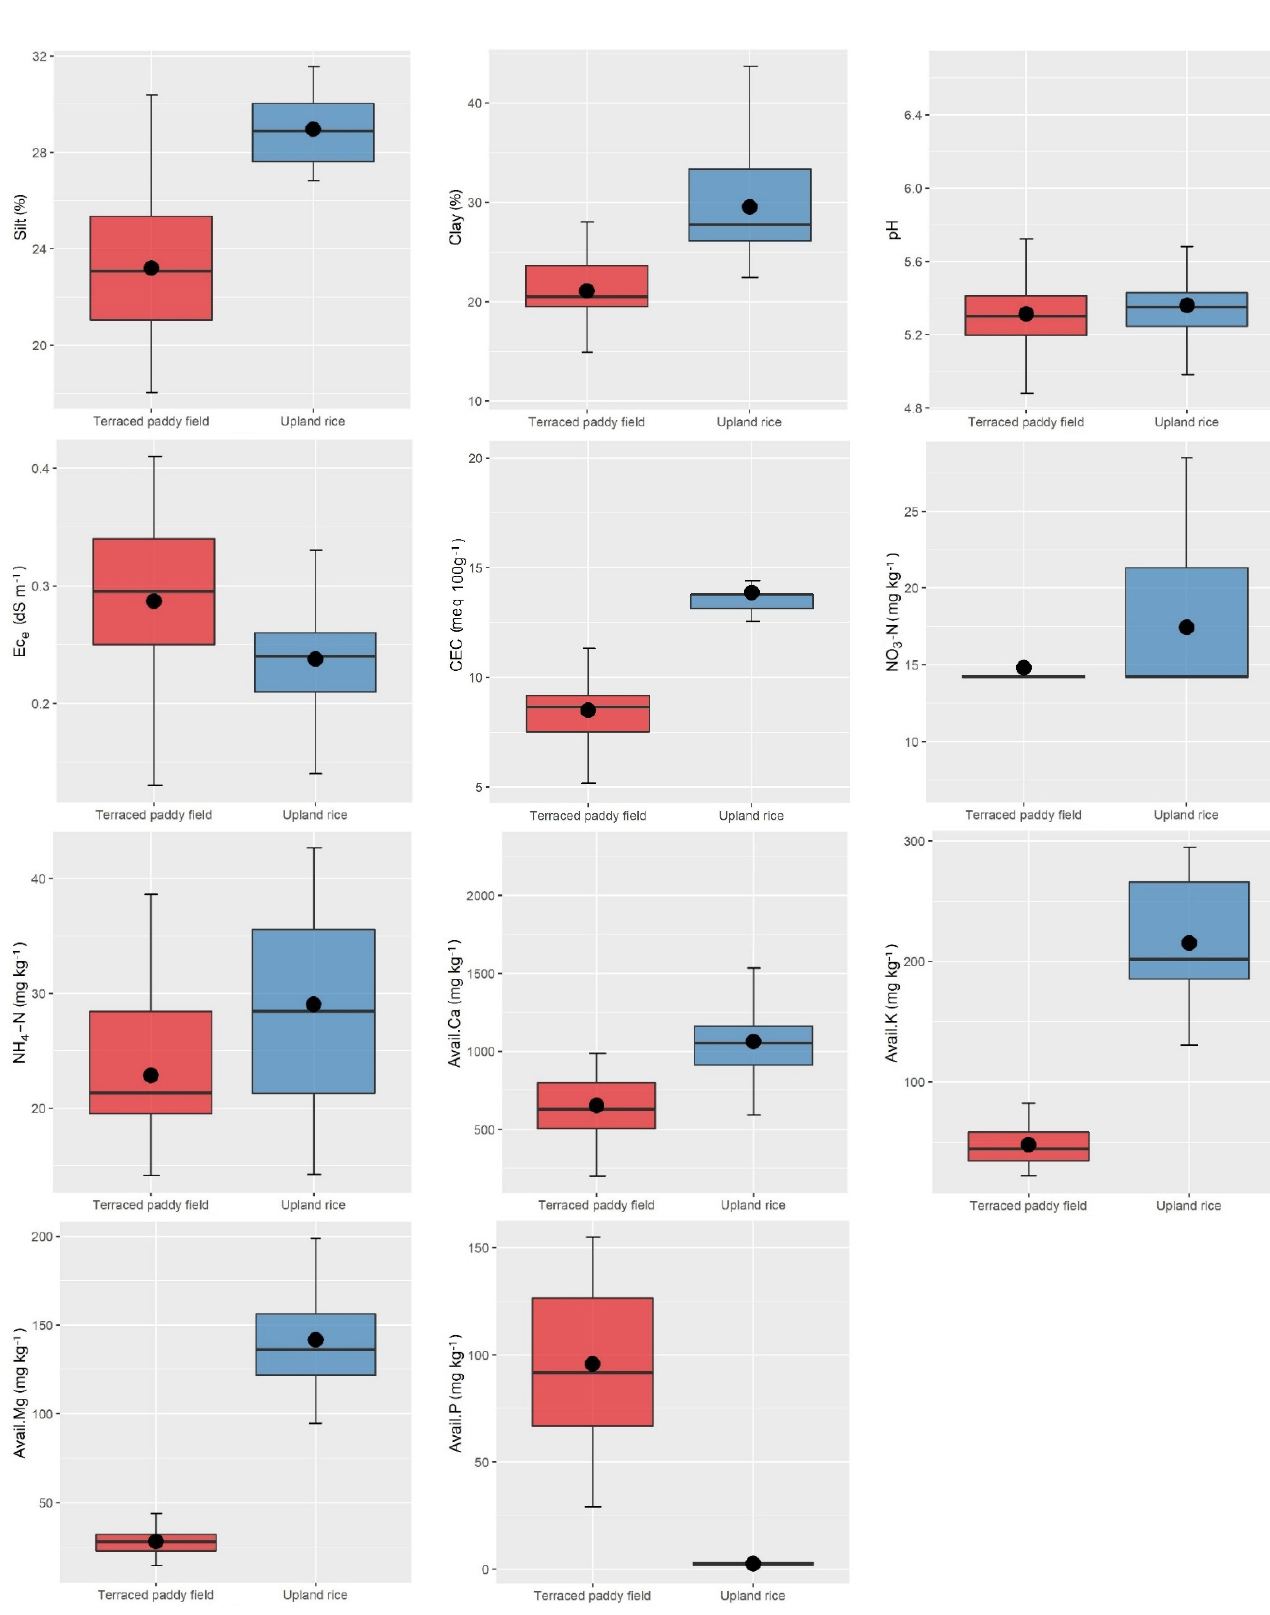
Figure 3. Comparison of soil physical and chemical properties between terraced paddy field and upland rice.